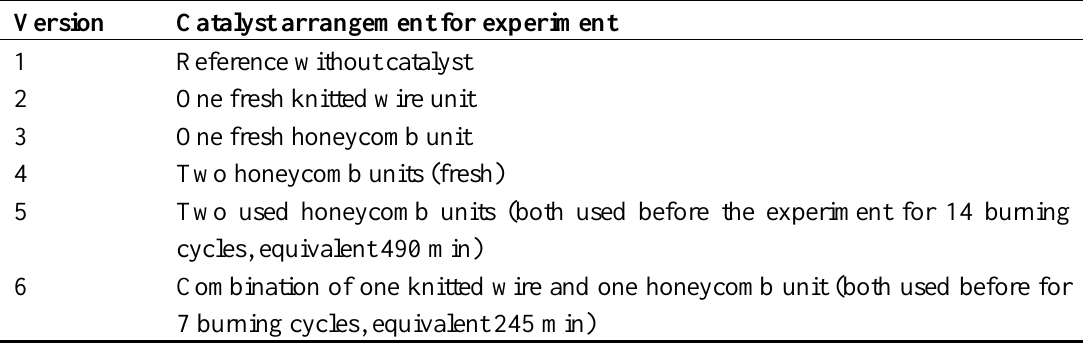
Table 3. Overview of the different versions for the